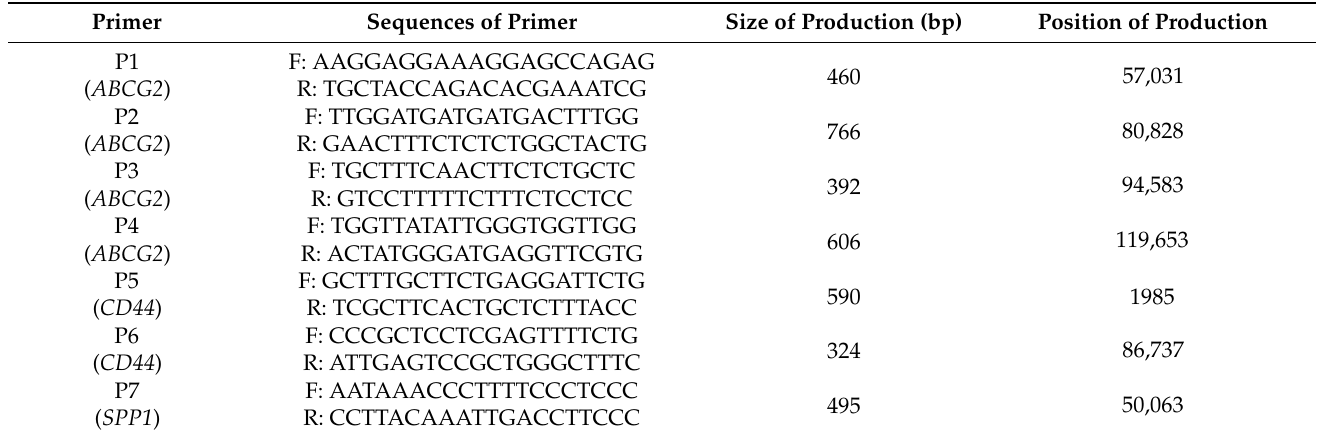
Table 1. Primer sequence and amplified fragment length of gene PCR